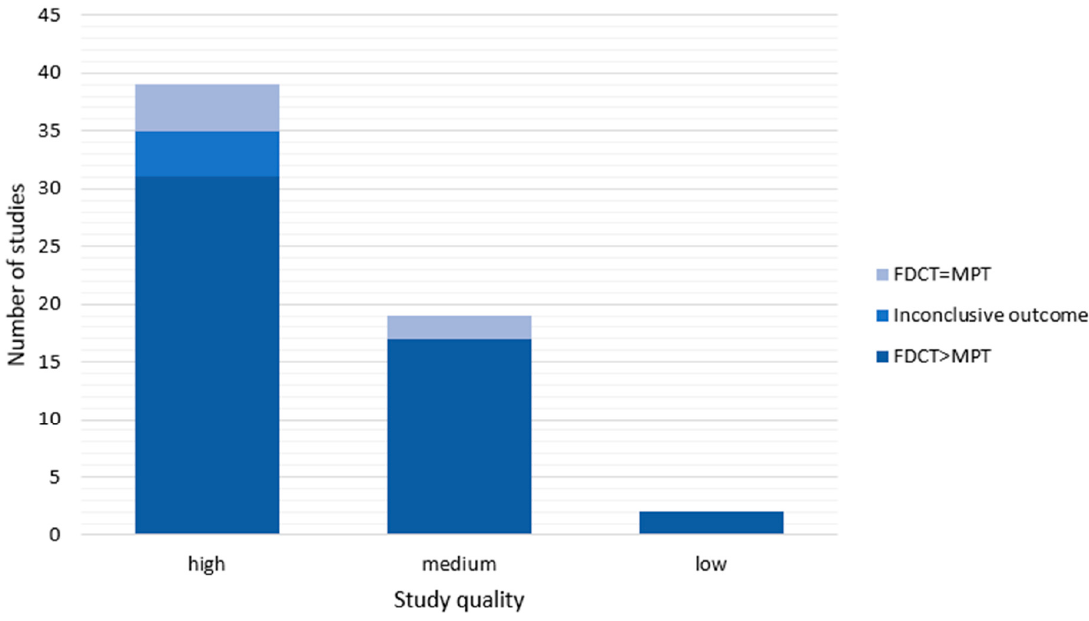
Figure 4. Number of studies with a certain outcome per study quality. FDCT, fixed-dose combination therapy; MPT, multipill therapy. Inconclusive outcomes: see Tables 5, B1 (Appendix B), and C1 (Appendix C) for additional information.